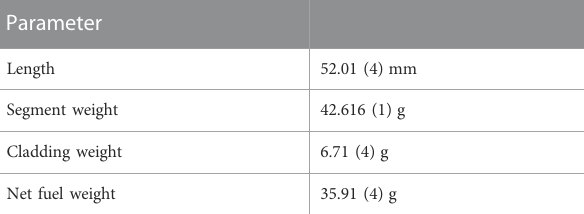
TABLE 1 Characteristics of the SNF segment sample that was used for the neutron measurements at the LHMA facilities of SCK CEN.